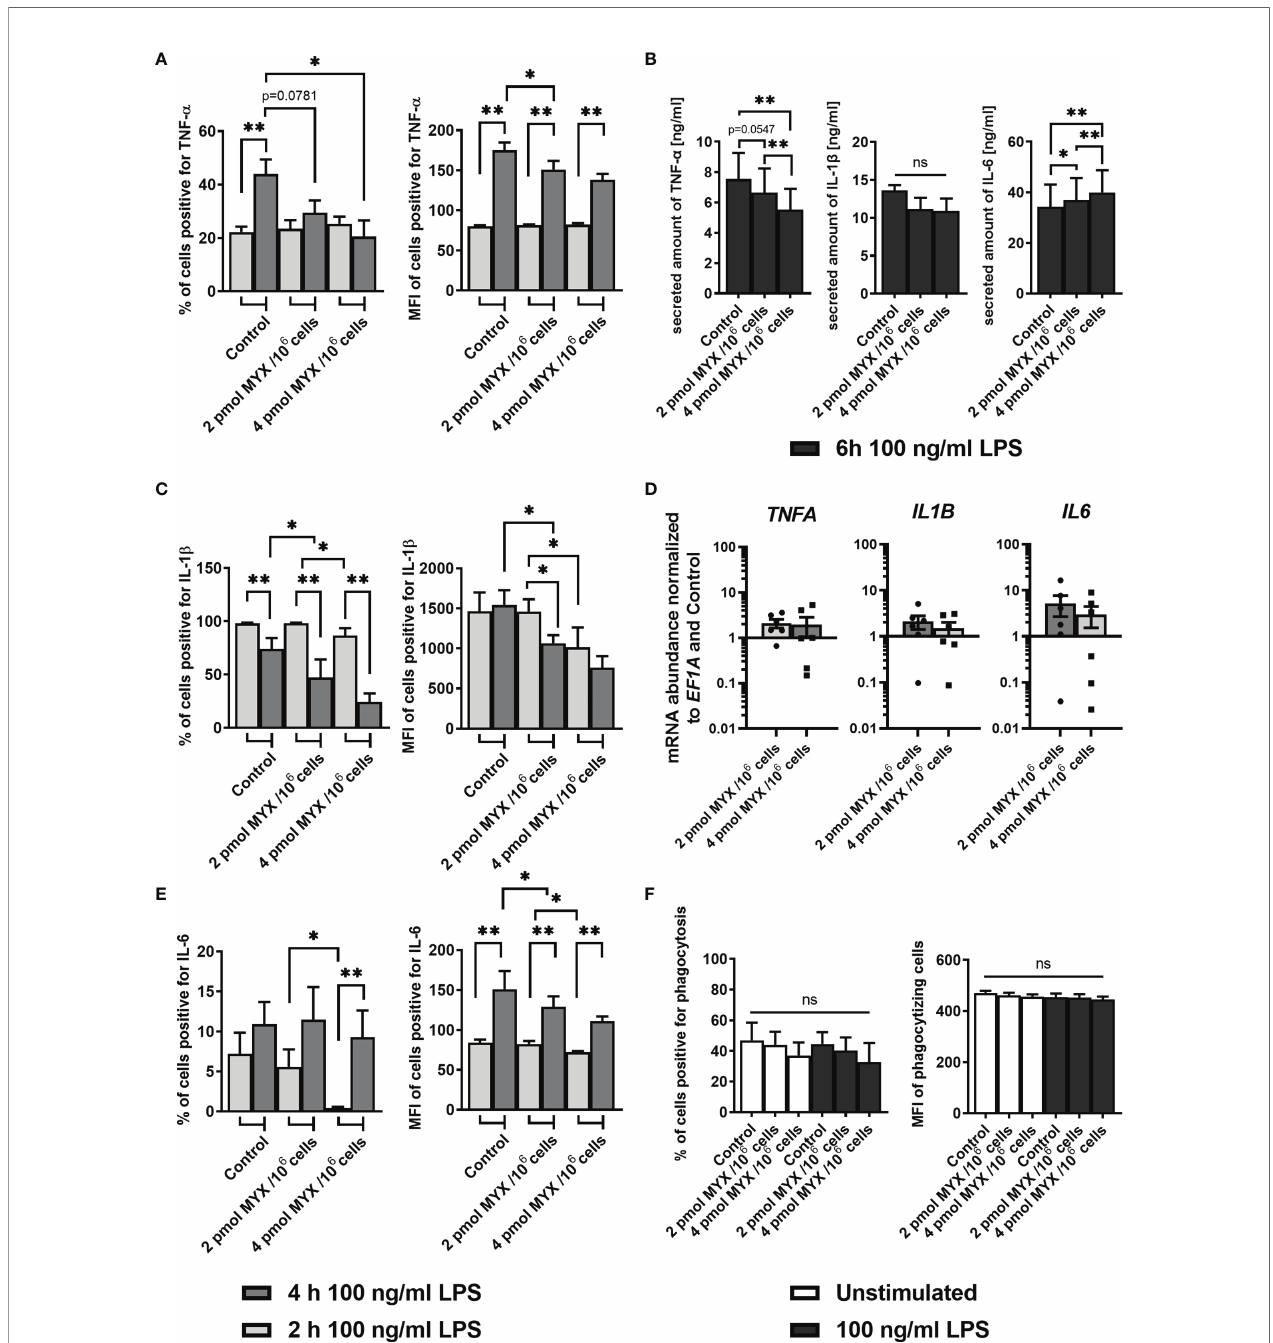
FIGURE 4 | Metabolic restriction with MYX modi fi es the kinetics of the production of in fl ammatory cytokines but has no effect on phagocytosis. (A – C) Percentage and median fl uorescence intensity of quiescent and stimulated (100 ng/mL LPS) human monocytes positive for intracellular staining of (A) TNF- a , (B) IL-1 b and (C) IL-6 in the presence or absence of MYX (pmol/10 6 cells) or vehicle control (1% (v/v) DMSO) under glucose free conditions. After 1 h of pre-stimulation with or without LPS, cells were treated with Brefeldin A (10 µg/mL) and stained following further 1 or 3 h of incubation (mean ± SEM; n = 6; *p < 0.05; **p < 0.01; Wilcoxon signed rank test and Mann Whitney U test). (D, E) Monocytes were cultured in glucose-free conditions stimulated for 6 h with both 100 ng/mL LPS and 2 pmol MYX/10 6 cells (MYX1) or 4 pmol MYX/10 6 cells (MYX2) or LPS alone. (D) Secreted amounts of TNF- a , IL-1 b , and IL-6 were determined using ELISA (mean ± SEM; n = 8; *p < 0.05; **p < 0.01; Wilcoxon signed rank test). (E) Gene expression of TNFA , IL1B and IL6 was normalized to the expression of EF1A and to the respective control (mean ± SEM; n = 6; *p < 0.05; **p < 0.01; Wilcoxon signed rank test). (F) Percentage and median fl uorescence intensity (MFI) of monocytes positive for FITC-labeled E. coli bacteria after 1 h incubation in the presence or absence of LPS (100 ng/mL) and MYX (pmol/10 6 cells) or 1% (v/v) DMSO (vehicle control) under glucose free conditions (mean ± SEM; n = 6; Wilcoxon signed rank test). ns, not signi fi